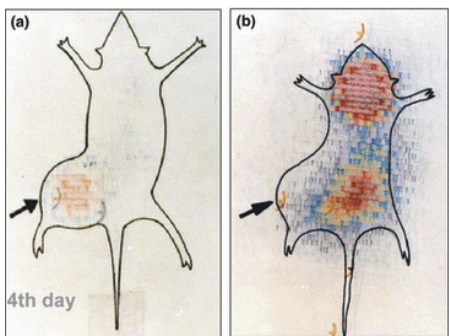
Figure 6. Imaging and selective delivery of radiations to tumors expressing hCG. (a) Whole-body scan of a JEG-3 tumor-bearing nude mouse on 4th day after injection of 131 I anti-hCG monoclonal antibody; (b) whole-body scan of a JEG-3 tumor-bearing nude mouse injected with 131 I irrelevant monoclonal antibody on day 4 Note . Adapted from “Immunological approaches against human chorionic gonadotropin for control of fertility and therapy of advanced-stage cancers expressing hCG/subunits” by Talwar GP, Gupta JC, Shankar NV. Am J Reprod Immunol.